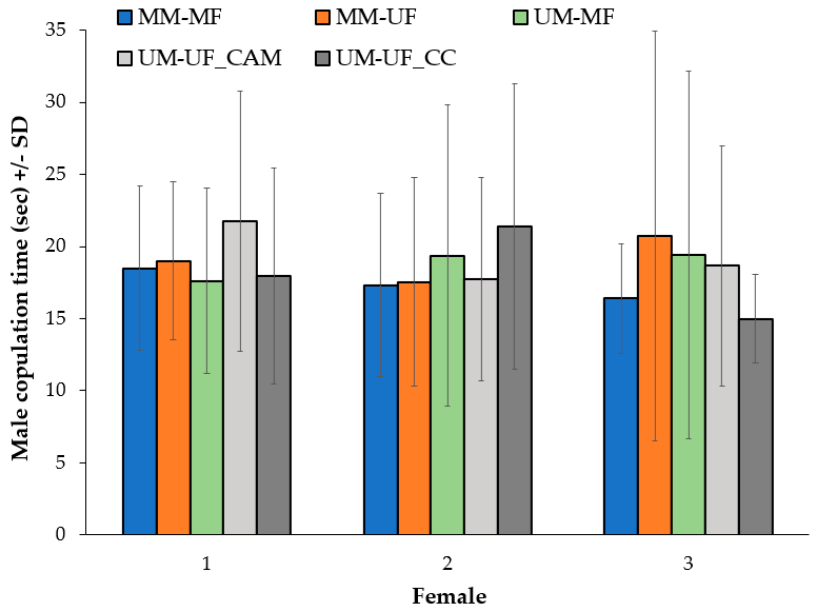
Figure 2. Male copulation time (s) (±SD) (male with three sequentially presented females) of all cross-combinations. Unmarked female (UF), marked female (MF), unmarked male (UM), marked male (MM), control colony (CC), and control application method-sham (CAM).